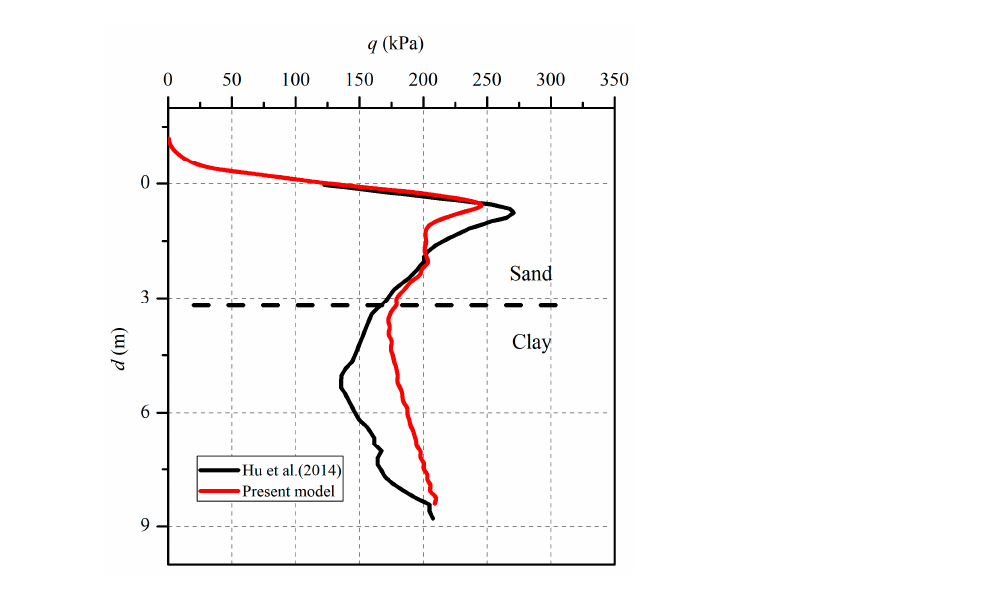
Figure 11. Penetration resistance profiles from centrifuge tests and numerical analysis (dense sand overlying clay) [11].